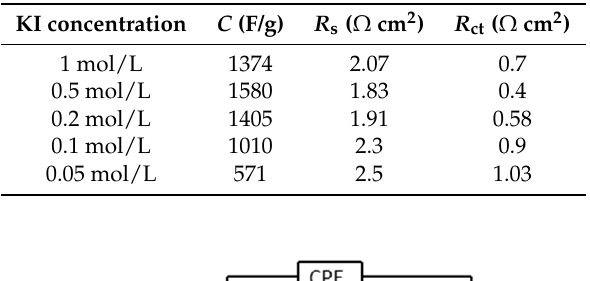
Table 2. The specific capacitance, electrolyte resistance and charge-transfer resistance at different KI concentration.